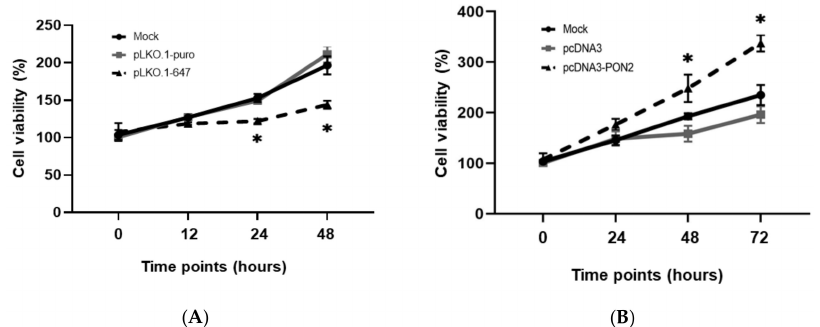
Figure 2. Evaluation of T24 cell viability. The e ff ect of PON2 silencing (panel A ) and overexpression (panel B ) on cell viability was assessed by the MTT assay. Cell viability was evaluated in the mock and cells treated with plasmids at di ff erent time points, between 0 and 72 h. All values are expressed as the mean ± standard deviation (* p < 0.05).